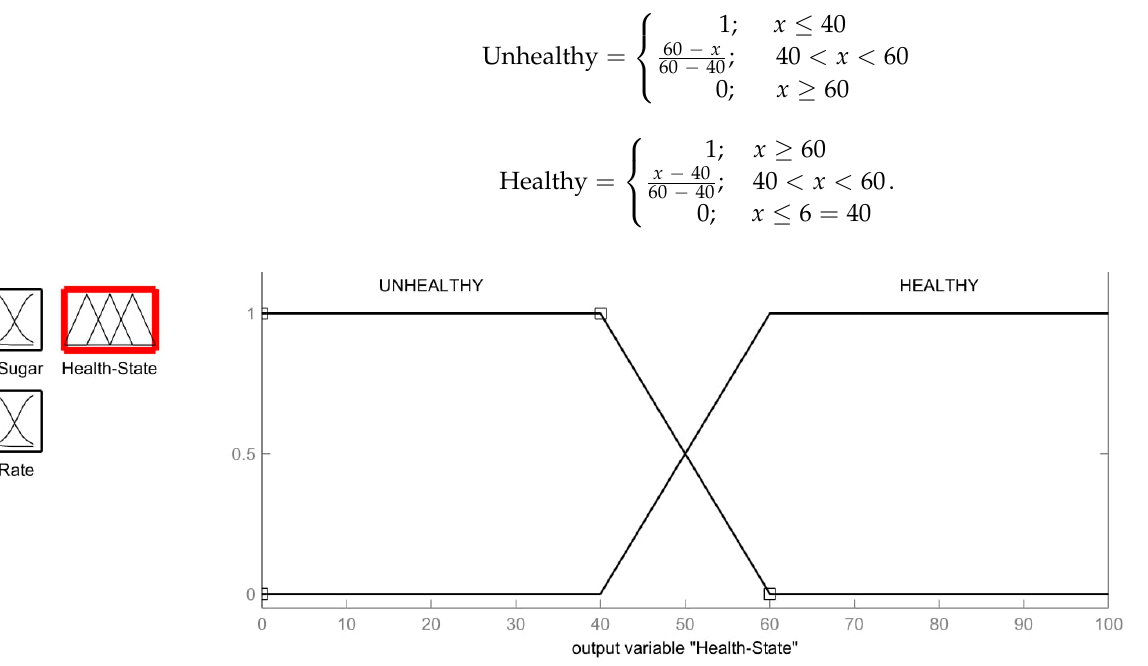
Healthy = (cid:3422)